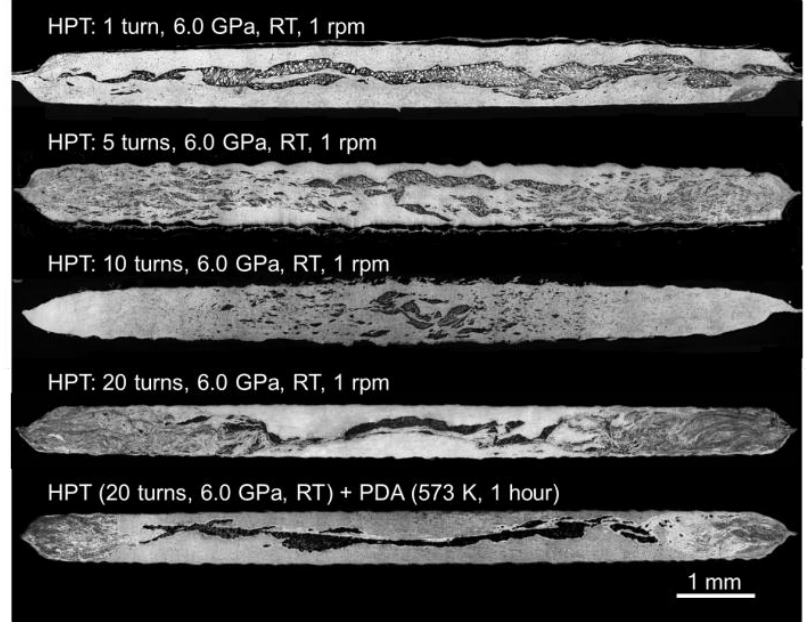
Figure 1. The vertical cross-sections of the Al–Mg system after HPT under a pressure of 6.0 GPa at room temperature for, from the top, 1, 5, 10, 20 turns and for 20 HPT turns followed by PDA [34,35].